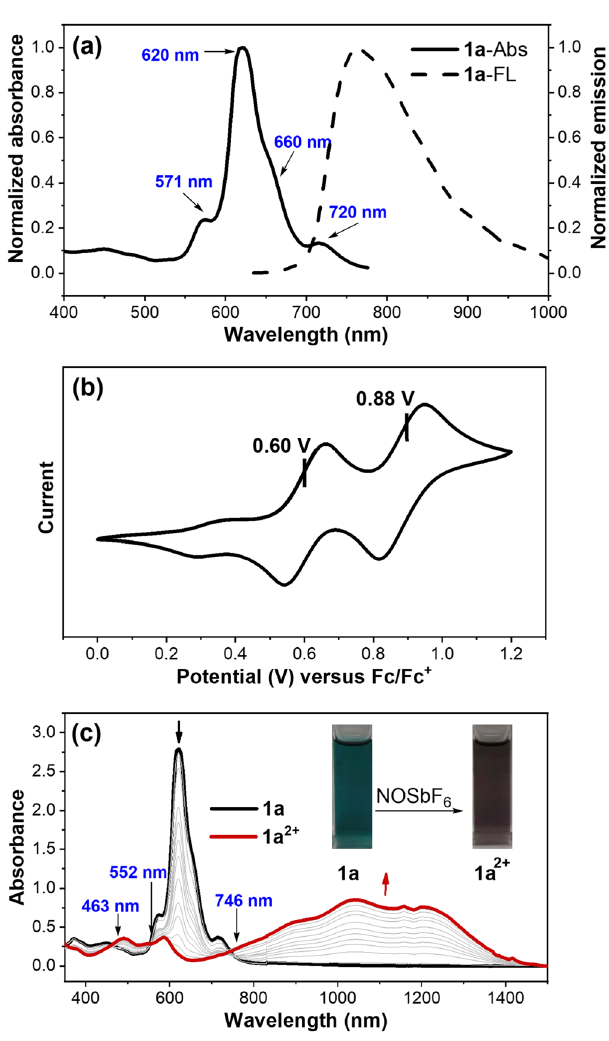
Fig. 3 Photophysical and electrochemical properties of 1a. a Normalized absorption and emission spectrum of 1a . b Cyclic voltammogram of 1a in DCM with 0.1 M Bu 4 NPF 6 as the supporting electrolyte, Ag/AgCl as the reference electrode, and a Pt wire as the counter electrode and a scan rate at 20 mV/s. c Absorption titration for the chemical oxidation of 1a using NOSbF 6 as oxidant. Inserted are the photos of the